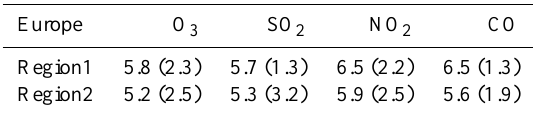
Table 3. M eff from Eq. (6). Values have been calculated